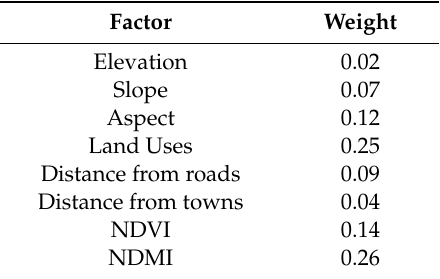
Table 2. Weights derived from the Analytical Hierarchy Process (all the stages of the AHP are thoroughly described in the Appendix A).